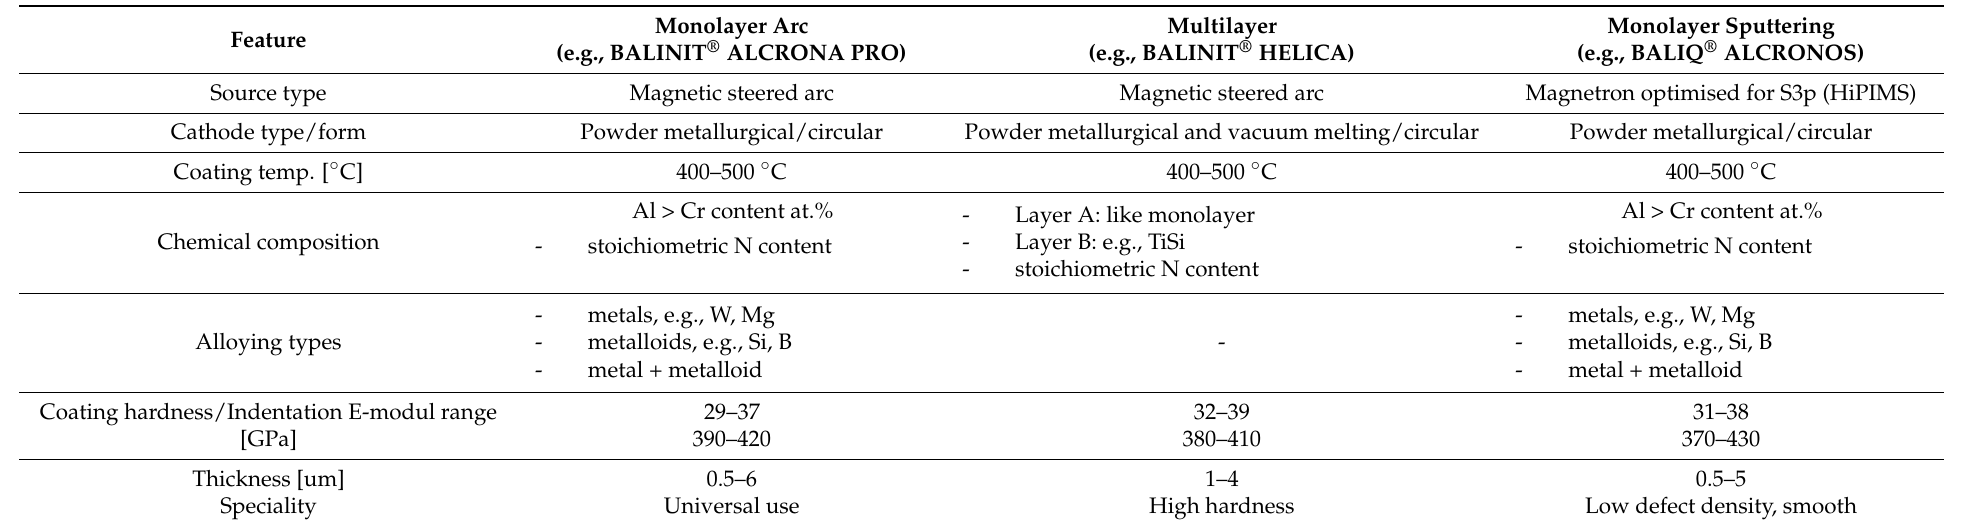
Table 3. Brief characteristics of selected industrially applied AlCrN-based coating